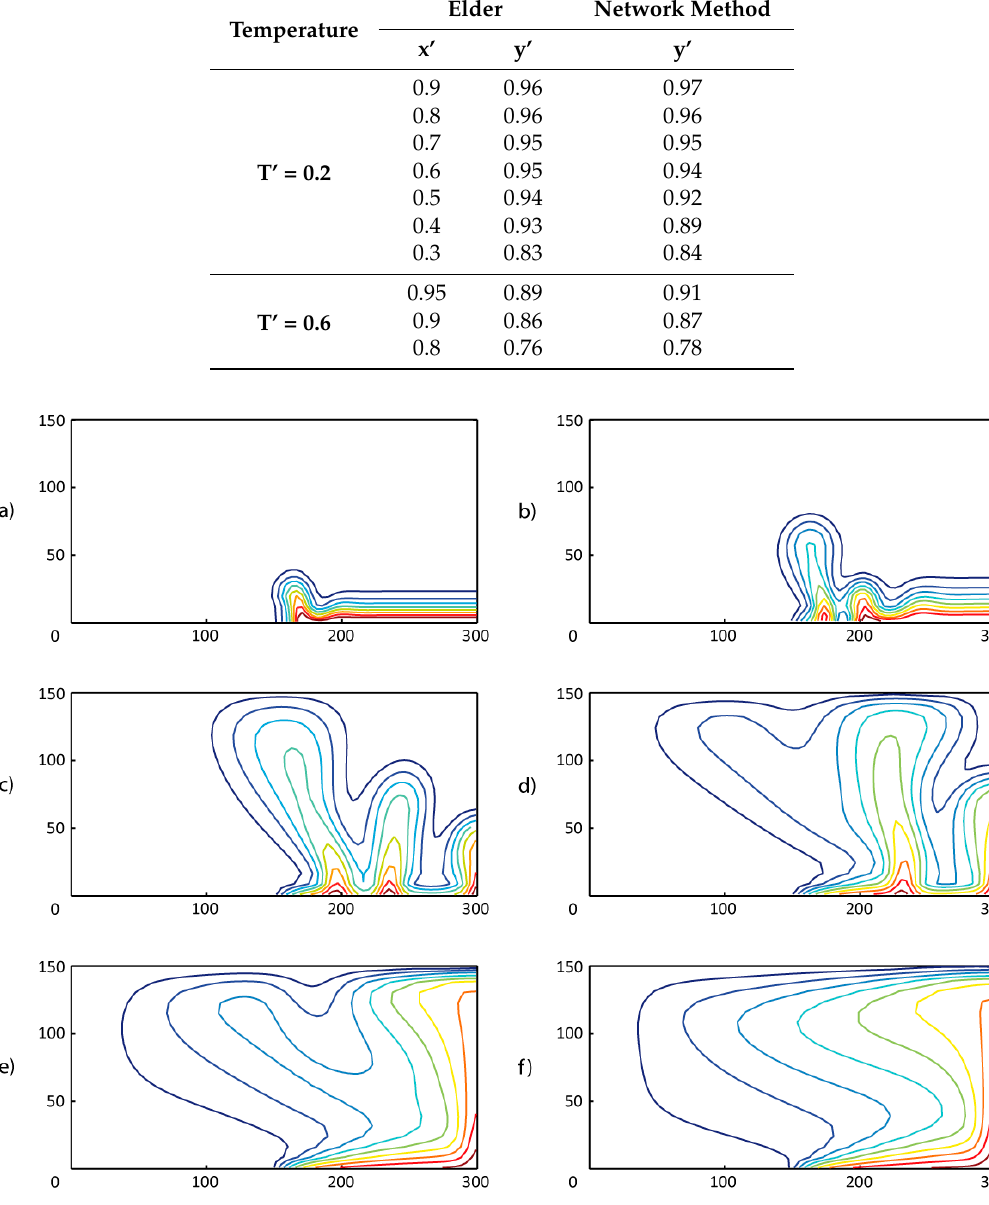
Table 4. Comparison of network method and Elder solutions for the isolines of temperature 0.2 and 0.6.